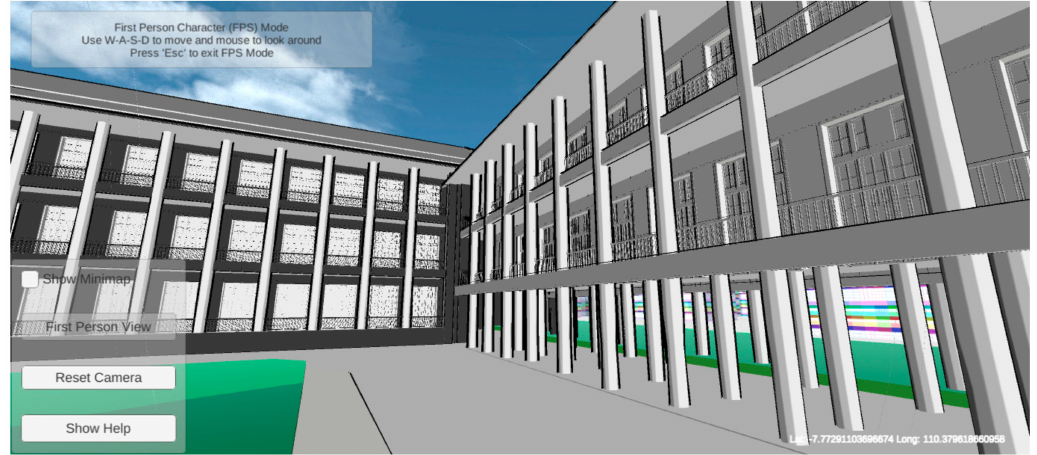
Figure A1. Screenshot of First-Person View (FPV)